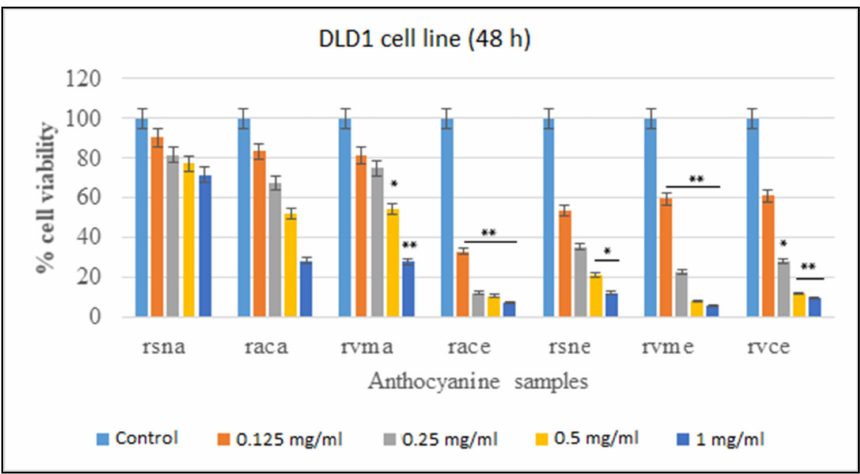
Figure 2. The antiproliferative effects of anthocyanines for 48 h application (* p < 0.05; ** p <